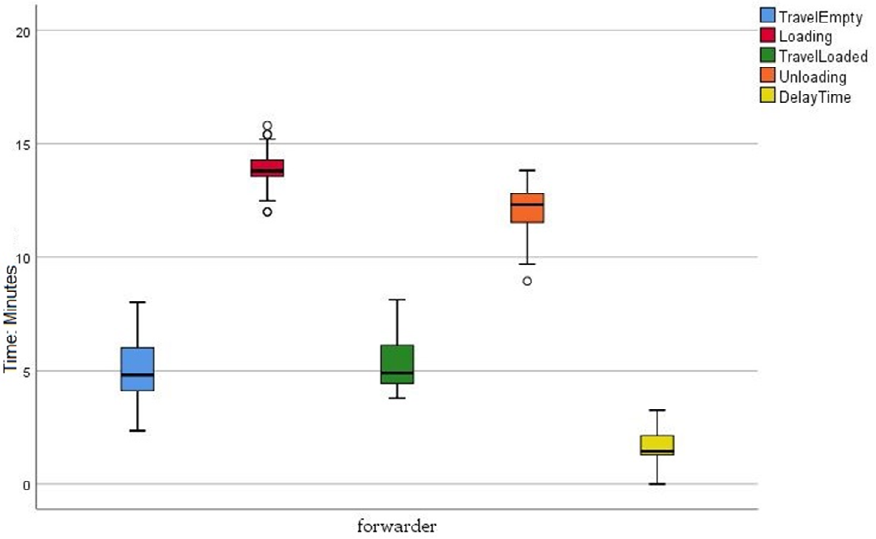
Figure 5. Time consumption of work element for scenario (iii). The boxes include the variability of the data between the 25th and the 75th percentiles. The horizontal black line represents the median. Whiskers are the largest and smallest values that are not outliers.